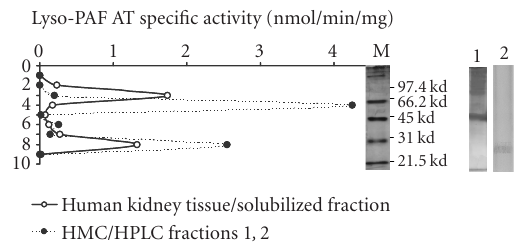
Figure 7. Native-PAGE electrophoresis: Lyso-PAF AT specific activities on native PAGE electrophoresis of solubilized fractions of human kidney tissue (- ◦ -) and active HPLC fractions 1, 2 of mesangial cells (- • -). The Log MW of standard proteins versus mobility was linear. Lines M , 1, and 2 represent the part of the gel stained by Coomassie Blue from molecular markers, human kidney tissue, and HMC, respectively.